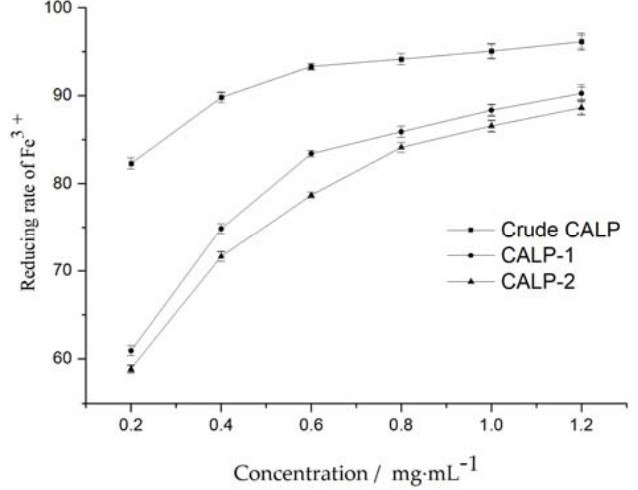
Figure 10. Iron (Fe 3+ ) ‐ chelating activity of MLPs at different